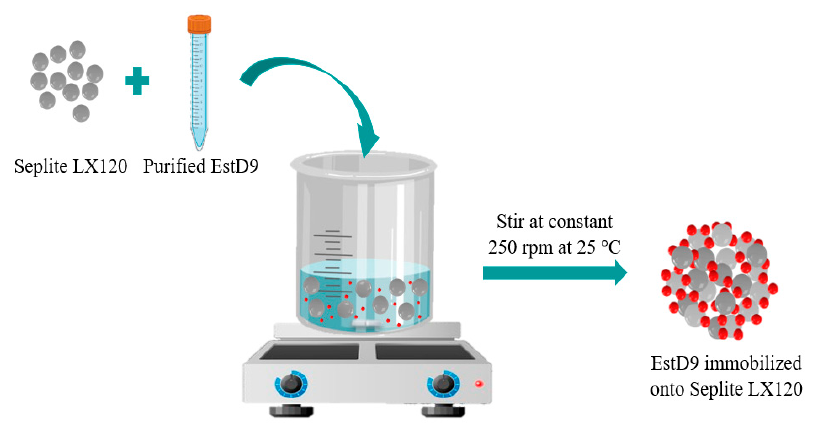
Figure 1. Schematic illustration of enzyme incorporation onto polymer support by physical adsorp- tion.